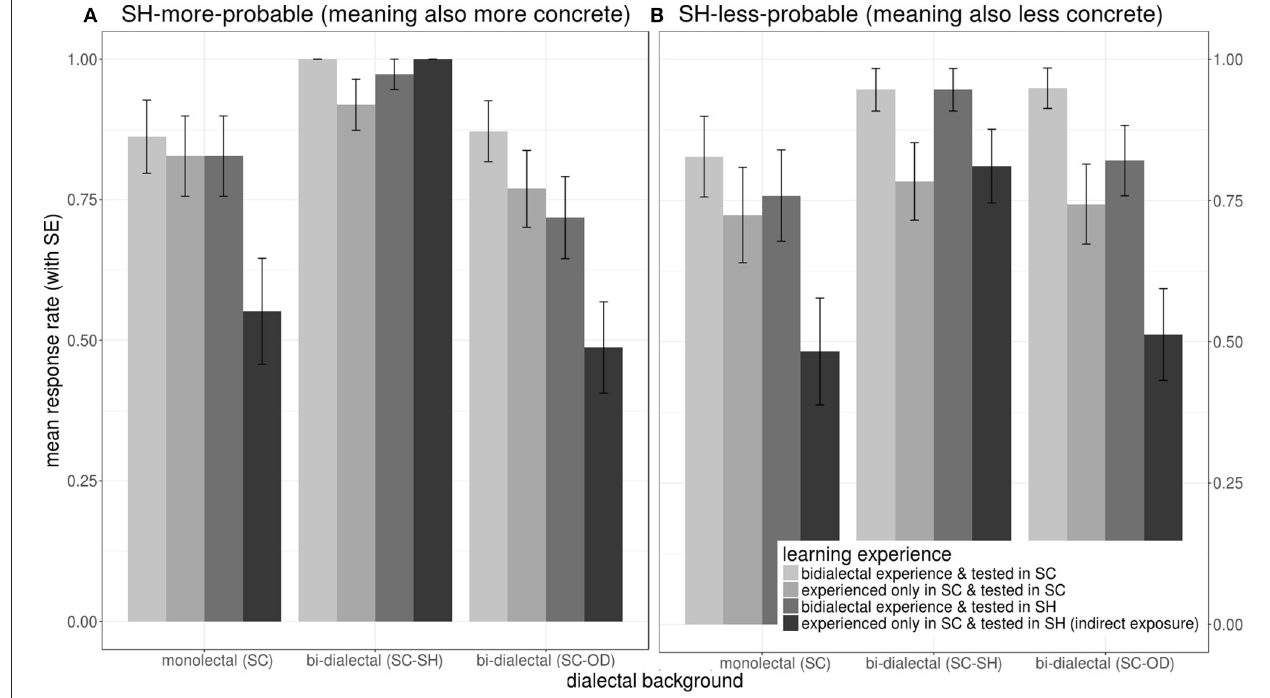
FIGURE 10 | Effects on mean response rates during the lexical production test, showing interactions of the learning experience (a combination of the participants’ exposure to target words prior to the naming task and dialect of operation in the naming task ), (color) and dialectal background (cluster), in response to SH-more-probable (A) (left panel) and SH-less-probable (B) (right panel)